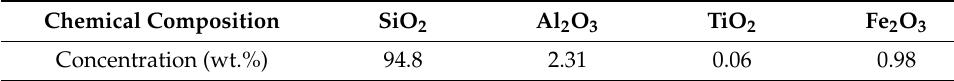
Table 1. The chemical composition of utilized aggregate (KS E 3076).